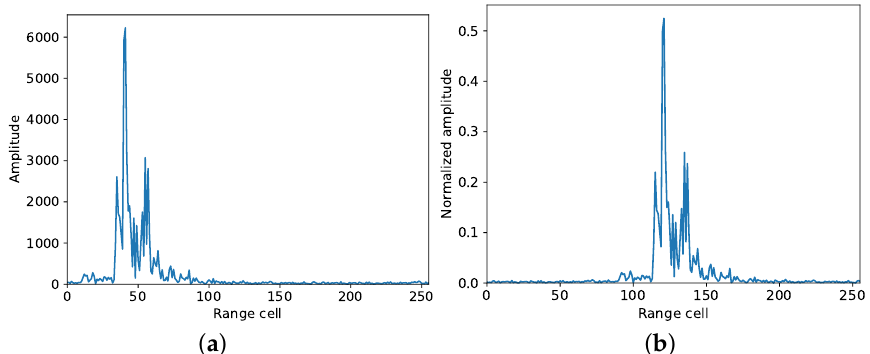
Figure 3. Schematic diagram of the raw HRRP sample and preprocessed HRRP sample. After data preprocessing, the intensity sensitivity and translation sensitivity of HRRP data have been eliminated. ( a ) Raw HRRP, ( b ) Preprocessed